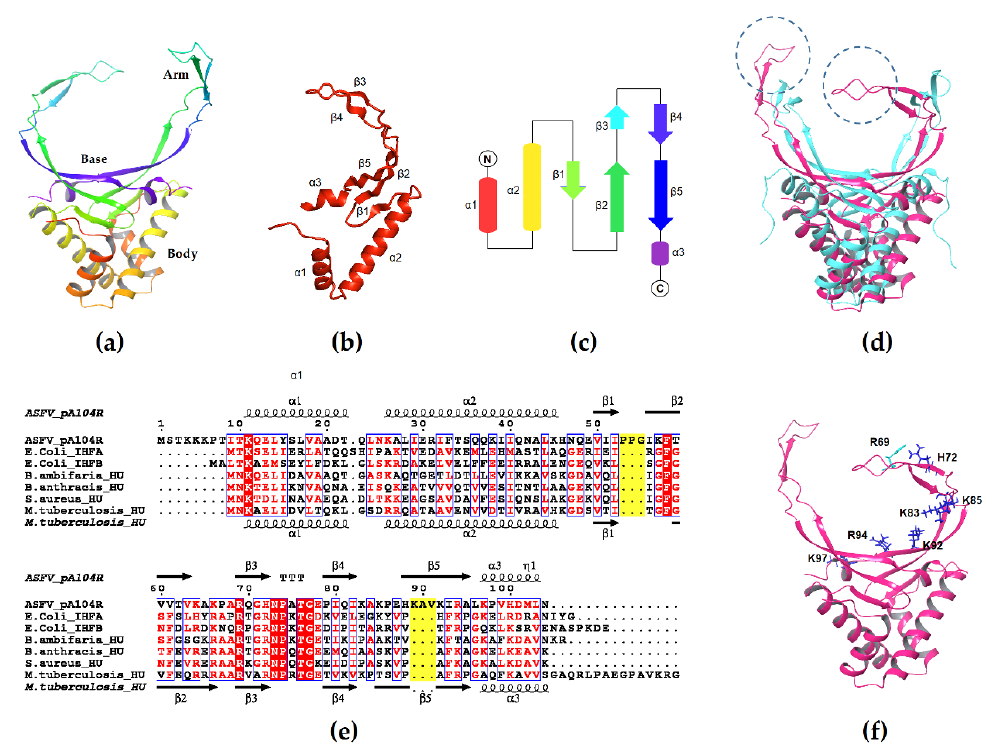
Figure 1. The structure of pA104R: ( a ) Model of dimeric pA104R generated by the Schrödinger Maestro suite [59]; ( b ) One protomer of the dimeric pA104R; ( c ) Topological diagram of secondary structural elements of the pA104R protomer; ( d ) Model of pA104R (magenta) superimposed with M. tuberculosis HU (cyan). The lengthened beta 2–3 and 4–5 loops are encircled; ( e ) Multiple sequence alignment of pA104R with other HU / IHF members generated by Clustal Omega (version 1.2.4) [60] using the HHalign algorithm and its default settings as described in [61] and ESPript 3.x [62]. The extra two sets of amino acids are highlighted in yellow; ( f ) The positively charged amino acid residues in the bottom (K92, R94, and K97) and arm regions (R69, H72, K83, and K85) of the pA104R protomer that contribute the majority of the protein-DNA interactions. The PDB codes of the structures are 6LMH (pA104R) and 4PT4 (mtbHU). Accession numbers are P68742, P0A6X7, P0A6Y1, B1YQ53, A0A2A7DF13, Q99U17, and